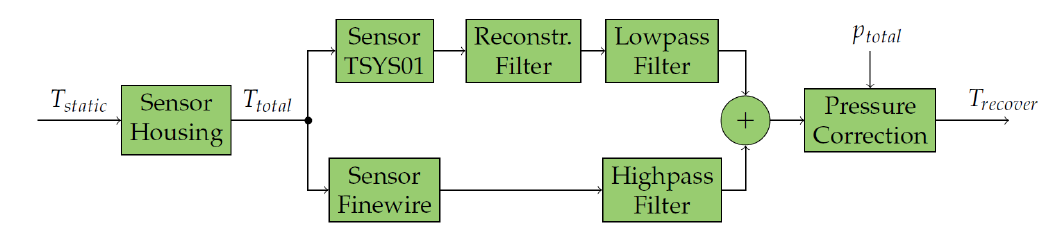
Figure 3. Signal flowchart of the algorithm to recover the total air